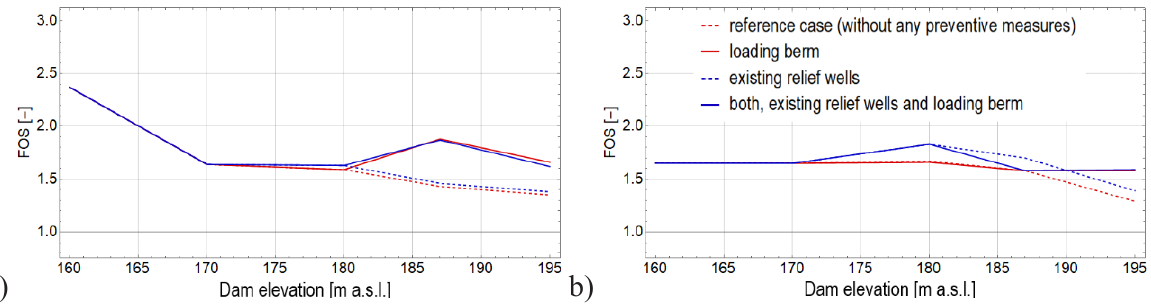
Figure 12: Evolution of FOS with the increase of the dam height: a) cross-section VIIIN and b) cross-section Fig. 12. Evolution of FOS with the increase of the dam height: a ) cross- section VIIIN and b ) cross- section VaN.